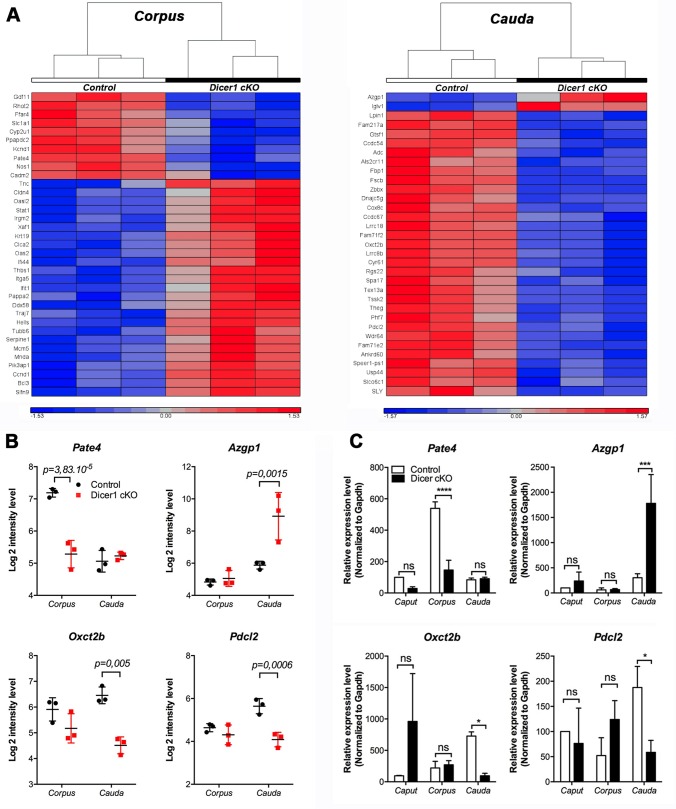
Impact of Dicer1-dependent factors on epididymal gene expression.(A) Transcripts with the most significantly altered expression in the corpus (left) or the cauda (right) epididymidis of the Dicer1 cKO mouse model are displayed on heat maps. Significance threshold: fold change > 2 or < −2, p-value < 0.002. n = 3 mice per group. (B) Relative Log 2 intensity levels of Prostate and testis expressed 4 (Pate4), Zinc-alpha-2-glycoprotein (Azgp1), Succinyl-CoA:3-ketoacid coenzyme A transferase 2B (Oxct2b), and Phosducin-like protein 2 (Pdcl2) in the corpus and cauda epididymidis of Dicer1 cKO and control mice after microarray analyses on n = 3 biological samples per group. (C) Expression changes of Pate4, Azgp1, Oxct2b and Pdcl2 were validated by qRT-PCR in the caput, corpus and cauda regions from control and Dicer1 cKO mice. qRT-PCR data shown as means and standard deviations of results obtained from n = 3 biological samples per group after normalization to Gapdh expression. Unpaired t-test corrected for multiple comparison using the Holm-Sidak method. ns: non significant, *p<0.05, ***p < 0.001, ****p < 0.0001.